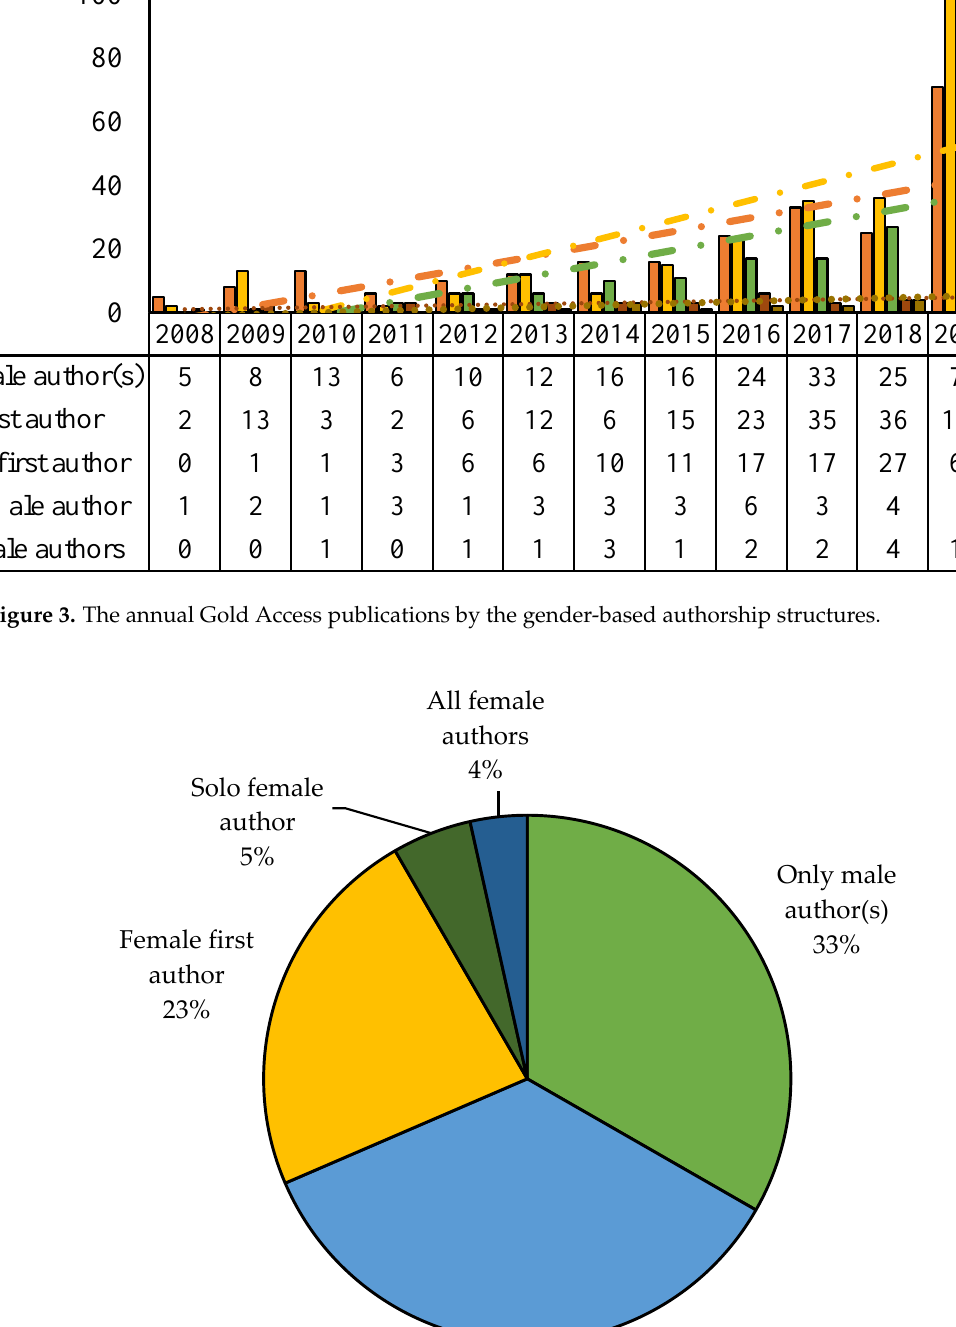
Figure 4. The proportion of Gold Access publications by gender-based authorship structures.